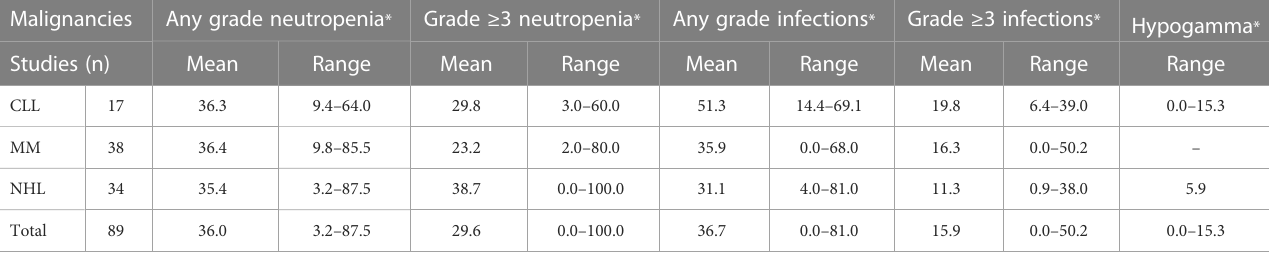
TABLE 3 Percentages of patients with CLL, MM, and NHL who had infections (any grade and grade ≥ 3), neutropenia (any grade or grade ≥ 3), or hypogammaglobulinemia.